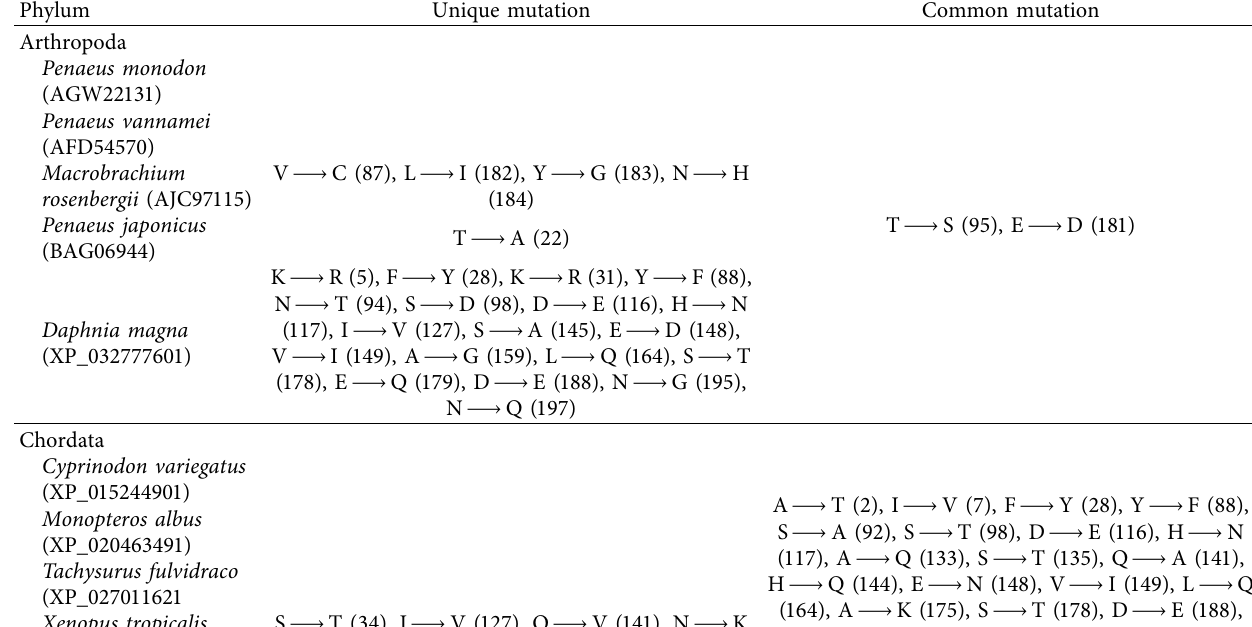
Table 2: Phyla-wise mutations in Rab7 sequences of different